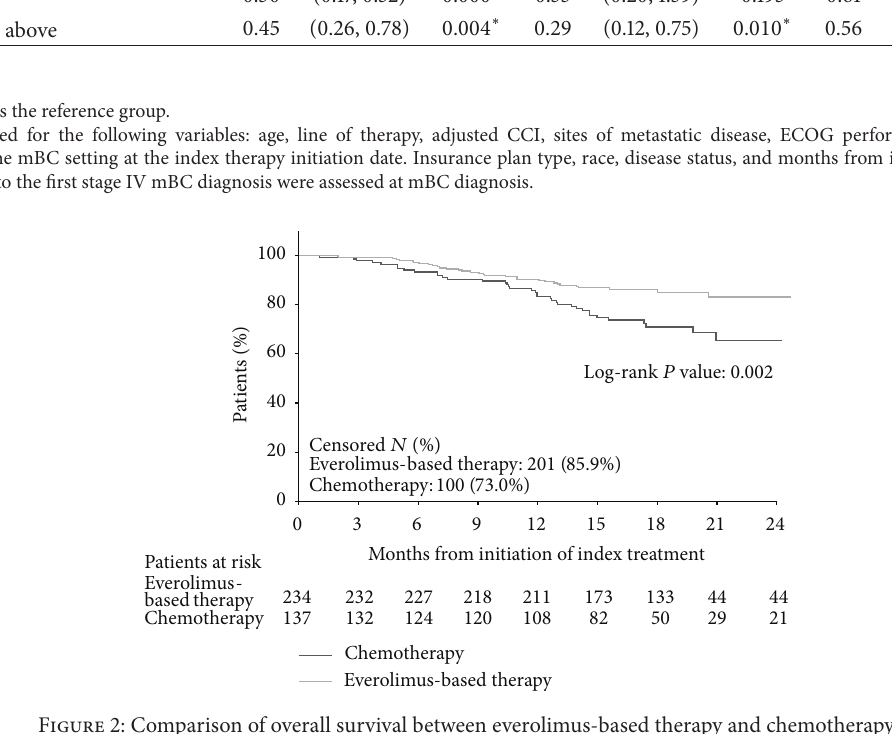
Figure 2: Comparison of overall survival between everolimus-based therapy and